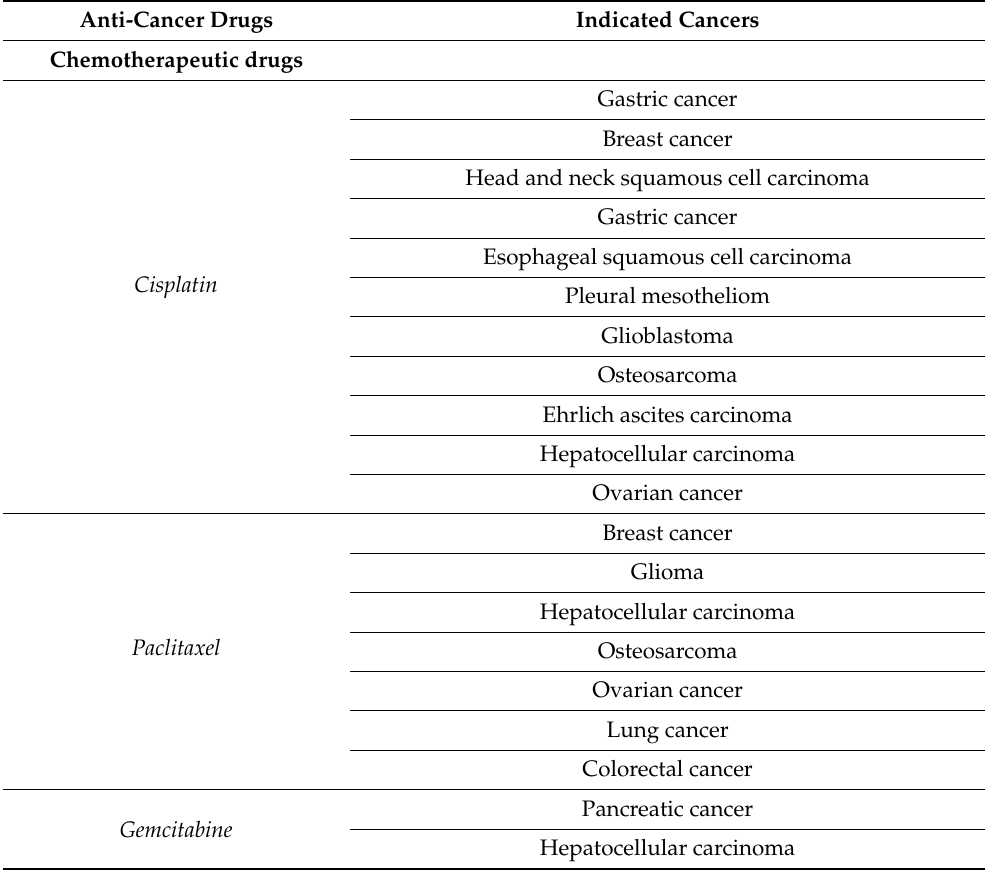
Table 1. A summary for anti-cancer drugs that easily develop